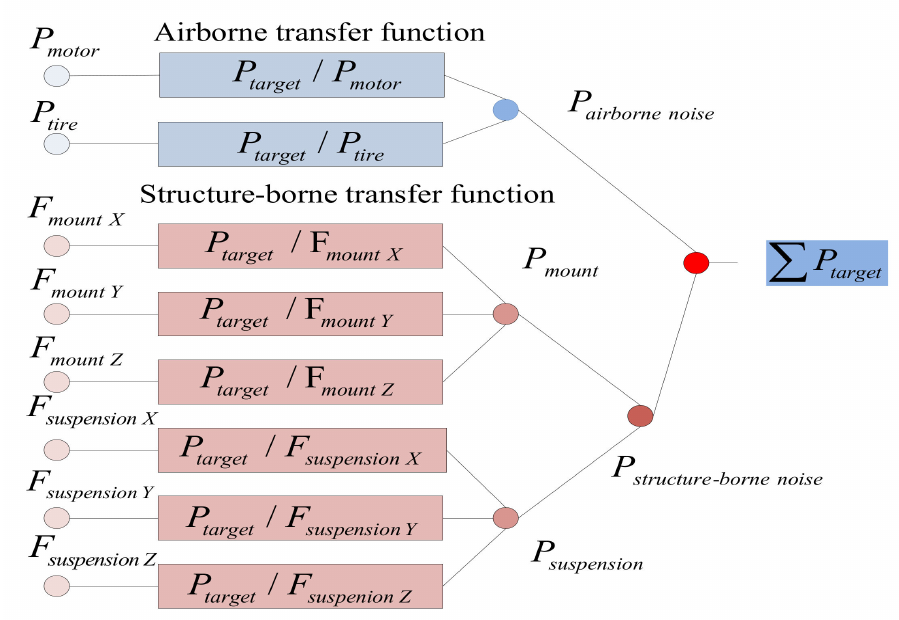
Figure 2. Schematic of the interior sound synthesis model of the